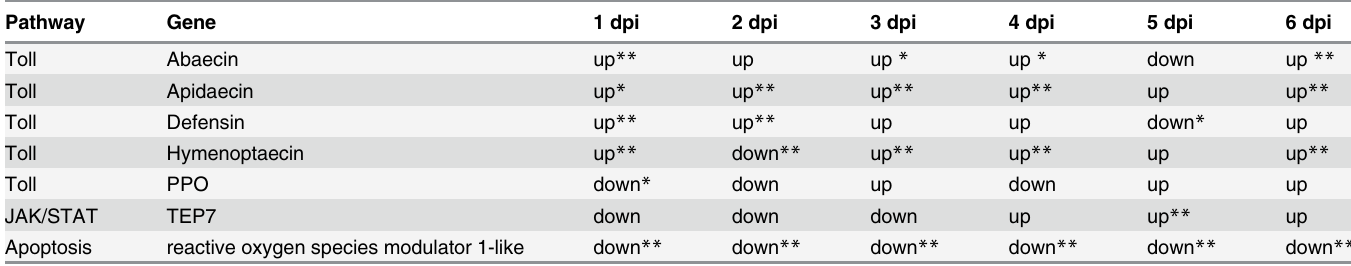
between infected and control bees, a pattern shared by Argonaute 2 (AGO2). The expression Table 1. Immunity related genes and involved